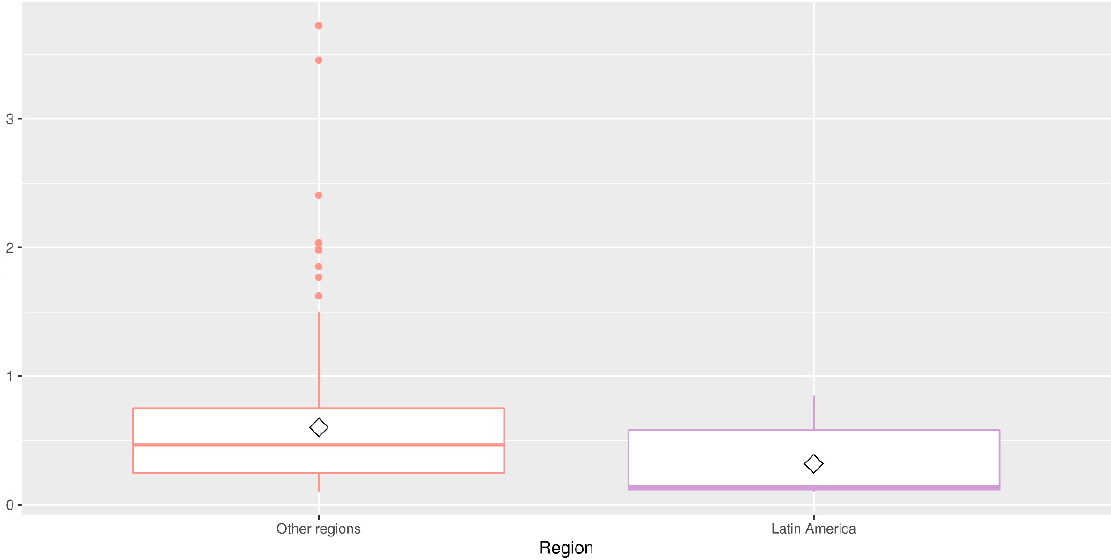
Figure 6. Global comparison of SJR between all regions. 3.5. Citations per Document in the last 2 Years Comparison The Anderson–Darling normality test proved that the citations per document distri- butions corresponding to the LAC and other regions groups were not normally distrib- uted, with p < 0.04 in both cases. The Cullen and Frey graph (Figure 7) shows that the distribution of the citations per document of journals of the LAC can be explained by a beta distribution, with min = 0.02, max = 2.36, median = 1.67, mean = 0.93, sd = 0.90, skew- ness = 0.48, and kurtosis = 1.55. On the other hand, this graph suggests that the citations per document of journals from other regions is close to a lognormal distribution, with min = 0, max = 7.37, median = 1.41, mean = 1.70, sd = 1.41, skewness = 1.42, and kurtosis = 5.56.